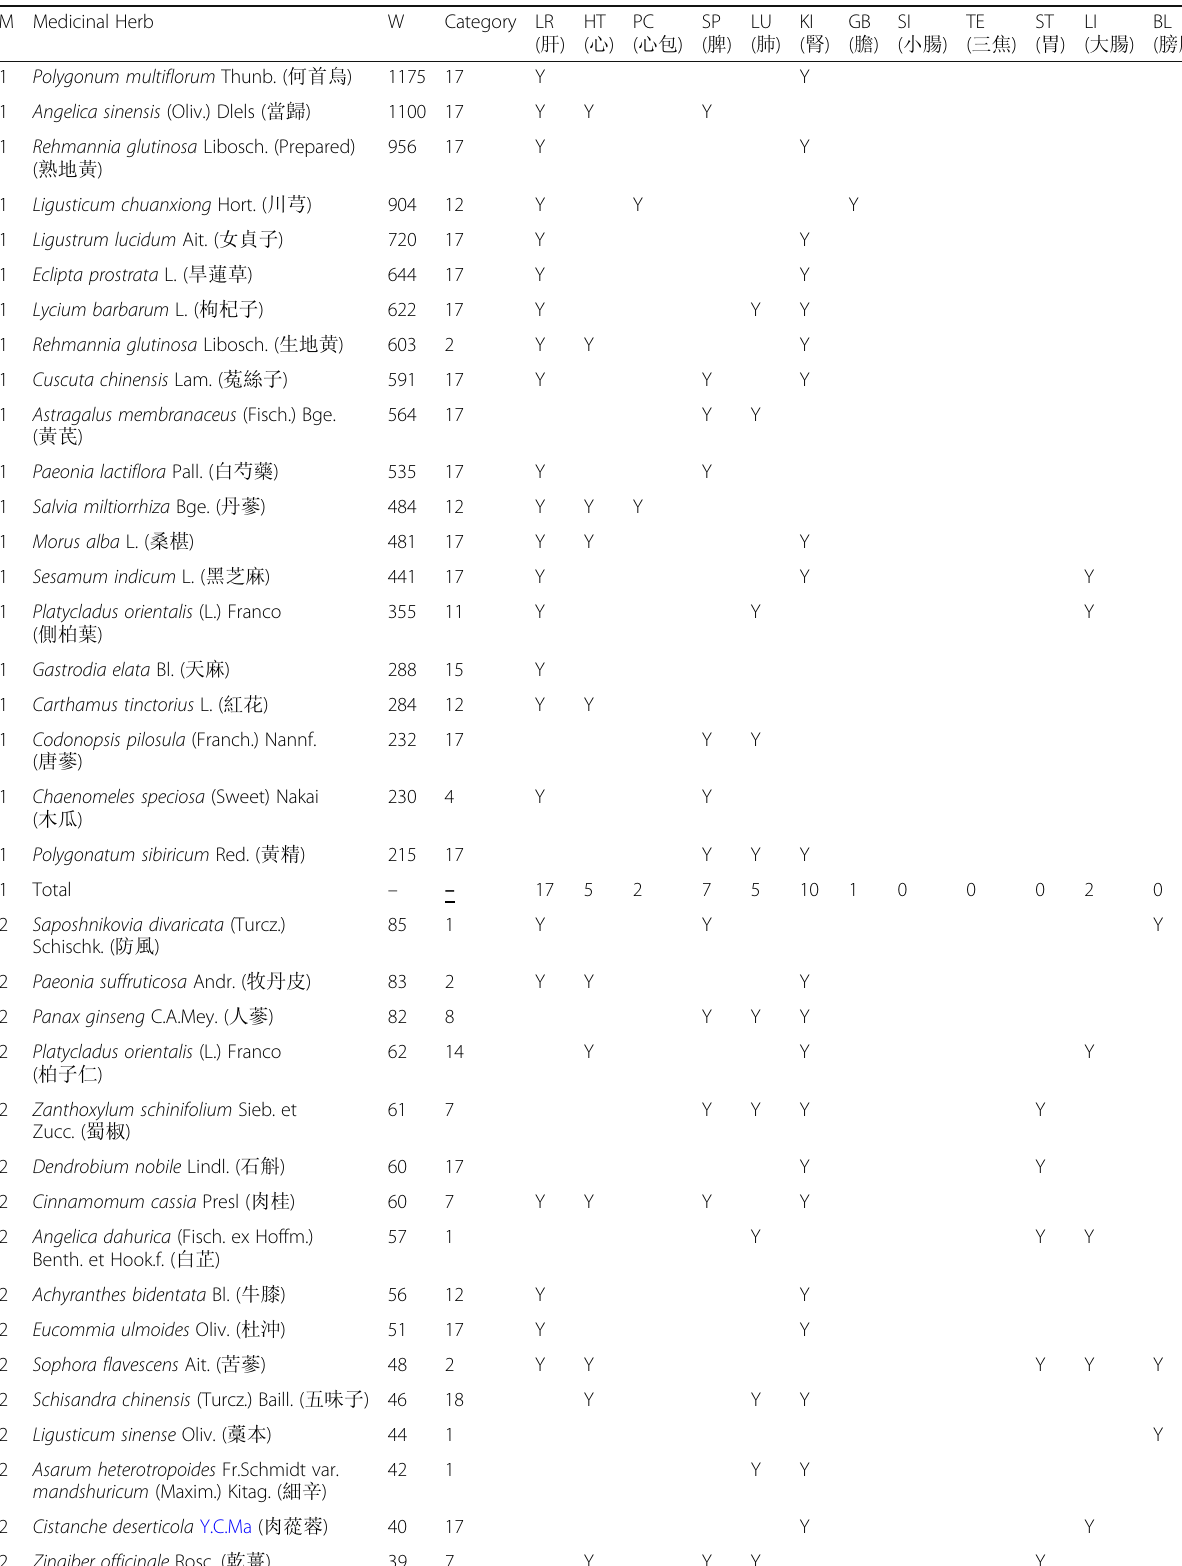
Table 4 Meridian tropism and category of the top 20 herbs in each network module M Medicinal